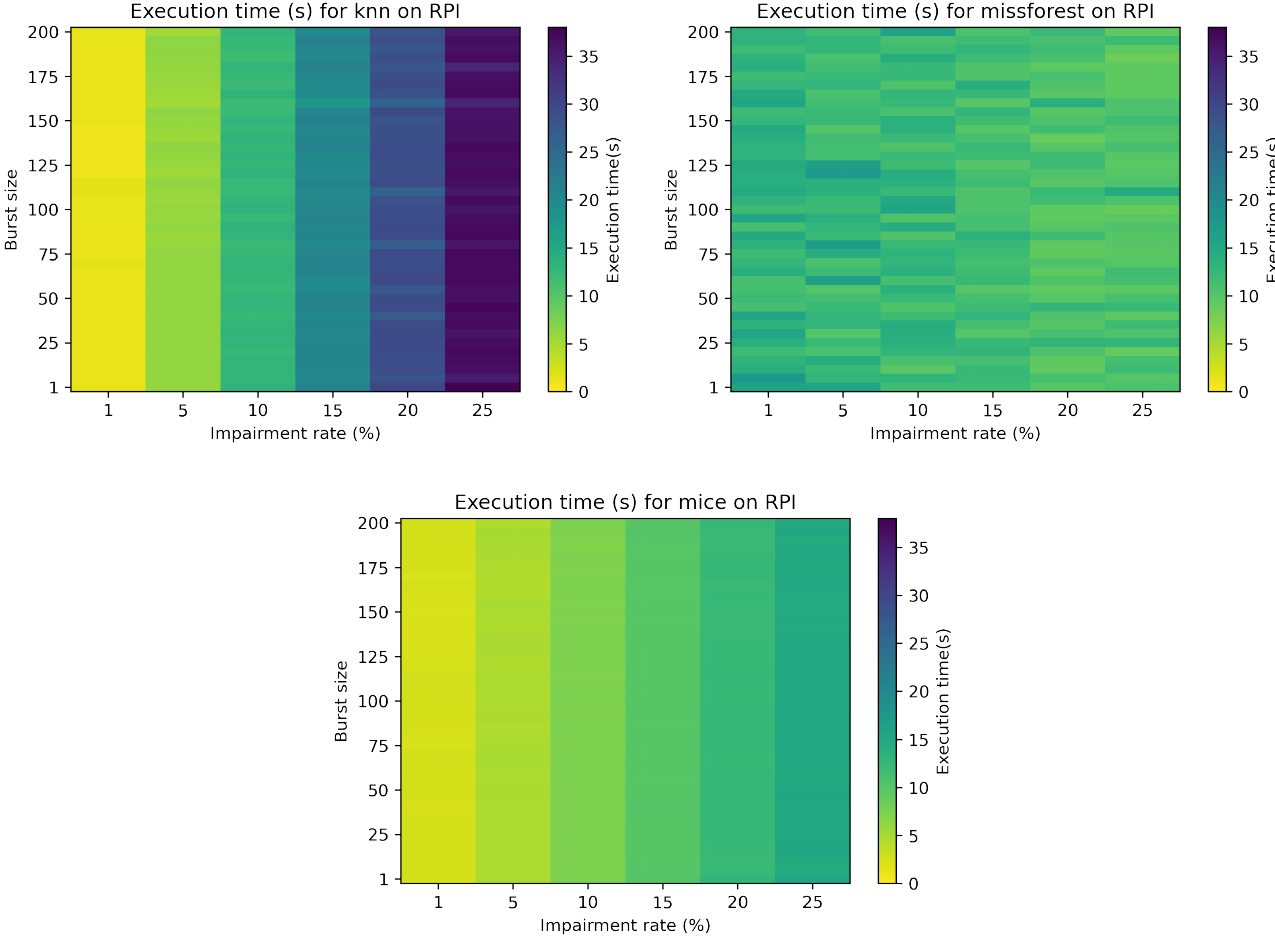
Figure 8. Colormap showcasing the execution time (s) in relation to the impairment rate and burst size for kNN, missForest and MICE data